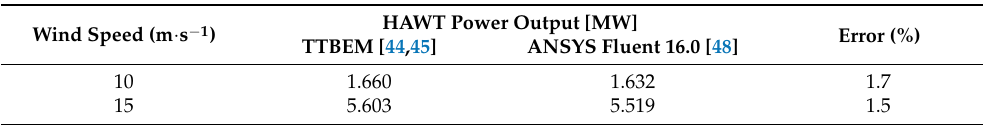
Table 6. Power output of present model in clean air flow, calculated by TTBEM [44,45] and ANSYS Fluent 16.0 [48].